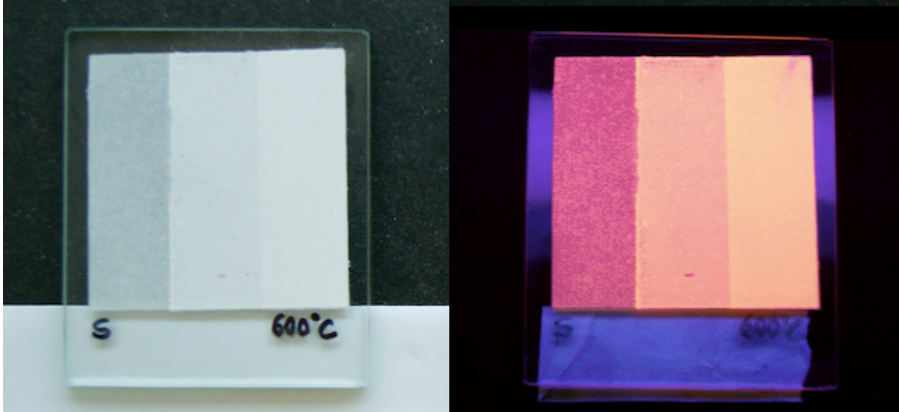
Figure 4. Screen-printed sodalite zeolite composite film depositions on glass. Sample viewed with visible light ( left ), sample viewed with UV light ( right ). Author’s photos. Figure created by author.